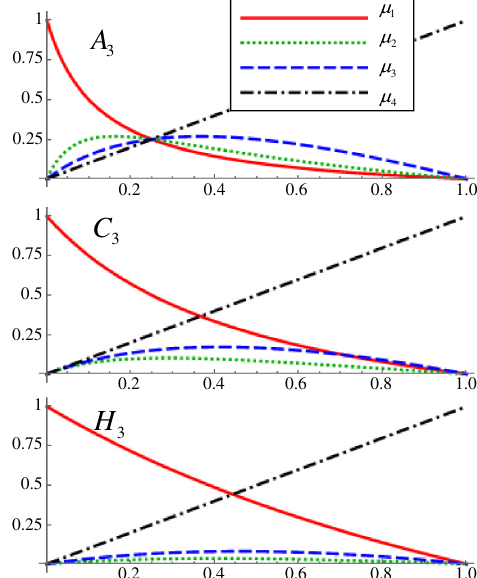
FIG. 2. The integrable mass families for four particles with the Coxeter symmetries A 3 , C 3 , and H 3 . The mass fractions μ m =M are plotted versus μ 4 (legend is in the top graph). The case i where all masses are the same μ Mass family C 3 includes two cases where two finite masses are the same, and H 3 includes